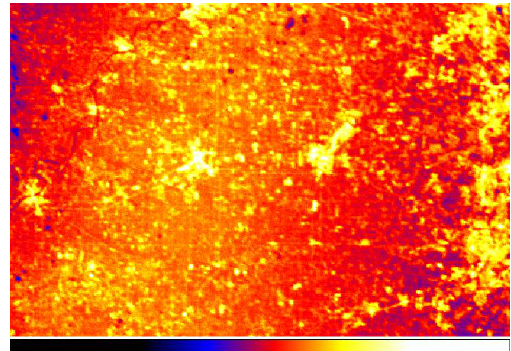
Figure 17. Zoom of white box from Figure